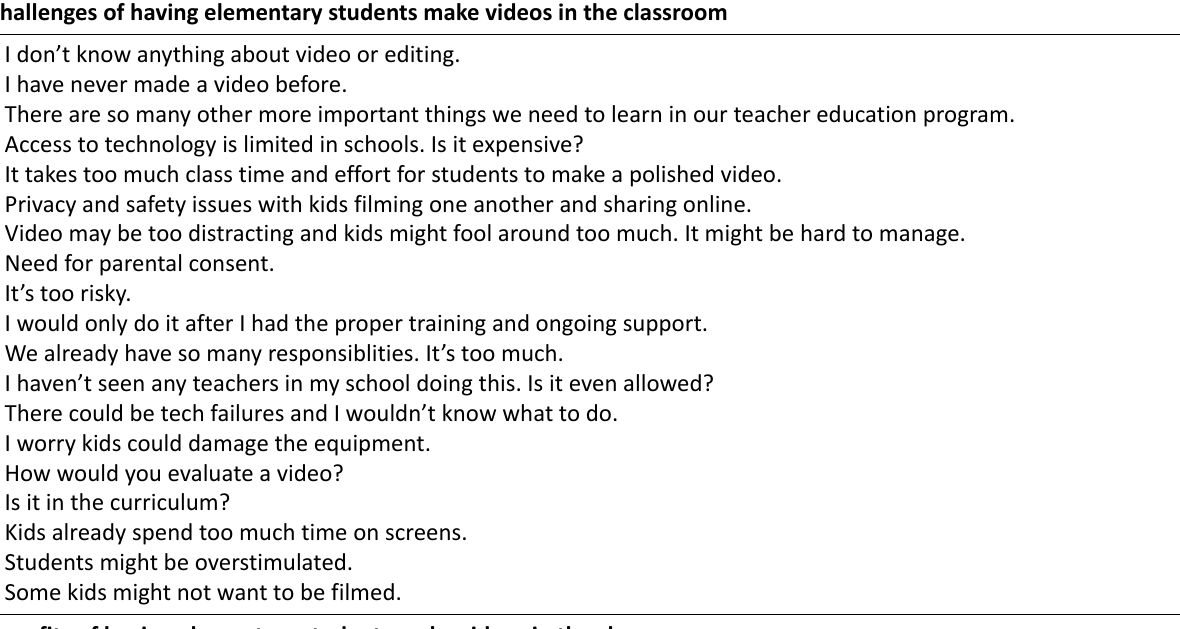
Table 1. Challenges and benefits of making videos in the elementary